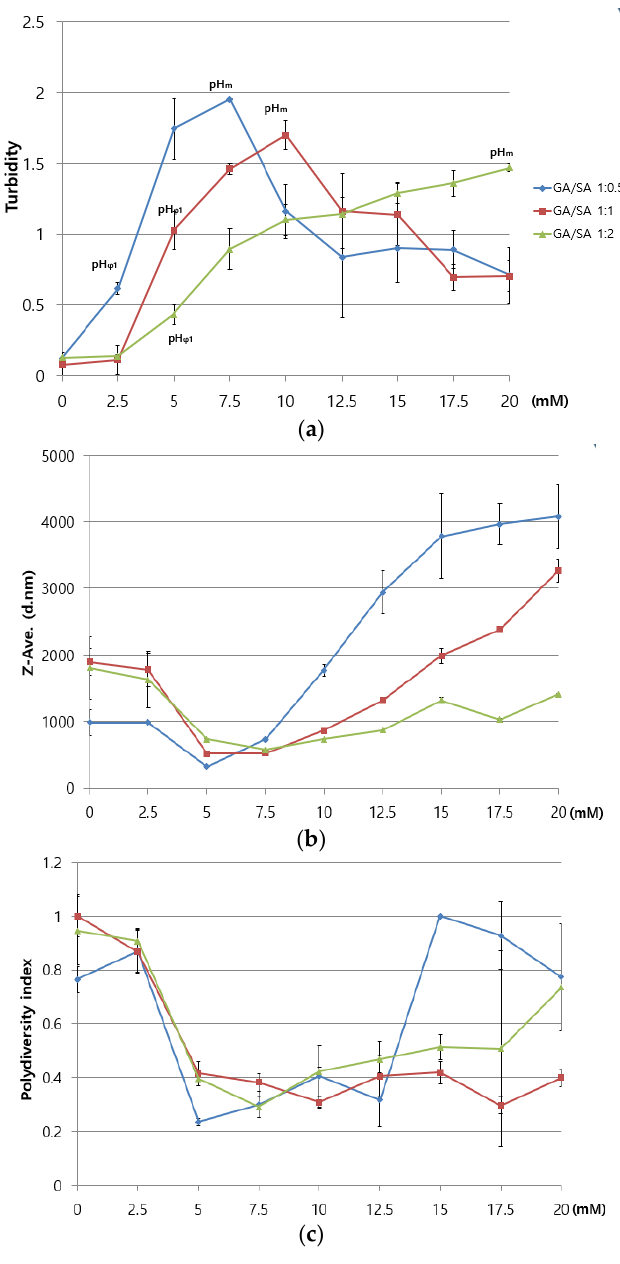
Figure 4. Phase diagrams of HWGA ‐ SA mixtures: ( a ) turbidity, ( b ) Z ‐ average, and ( c ) polydispersity index (PDI) as a function of the acetic acid concentration (mM). pH Φ : onset pH for phase separation; pHm: pH of maximum optical density.